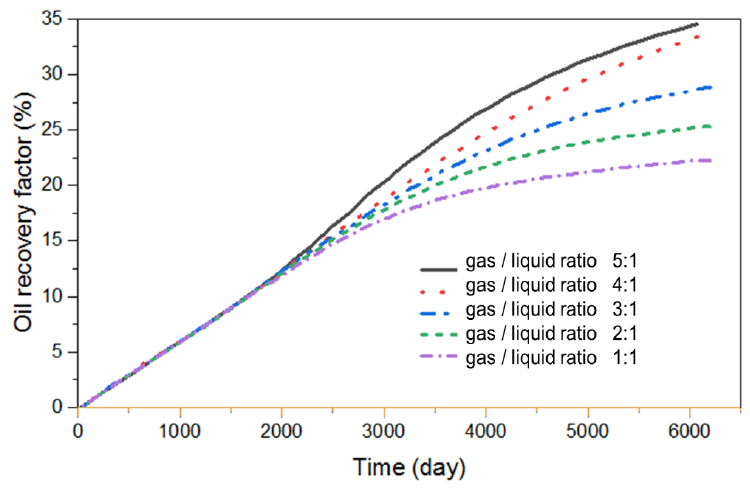
Figure 20. The comparison of huff-n-puff oil recoveries under different gas/liquid ratios.